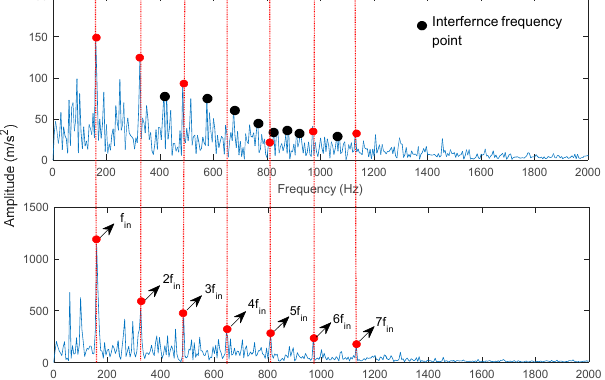
Figure 25. Comparison of computational cost for ECEEMDAN and CEEMDAN. 4.4.2. Case 2 Bearing with an Outer Raceway Fault In this section, ECEEMDAN is used to decompose the fault signal. A total of 14 IMFs were obtained under the condition of the optimal decomposition level (10 − 6 ). Then, the CF was employed to identify the IIM (Figure 26). The results show that CF 1 is the maximum, meaning that the first IMF contains the main information of the vibration signal. Meanwhile, complete ensemble local mean decomposition with adaptive noise ( CELMDAN) -kurtosis and variational mode decomposition (VMD) -kurtosis [36] are also utilized to extract the IIM. Figure 27 shows the identified result of IIM for the two methods. Moreover, minimum entropy deconvolution (MED) [37] combined with autoregressive filter (AR) (MED-AR) was used to identify the fault frequency. The first and the forth IMF were the identified IIMs for CELMDAN kurtosis and VMD kurtosis, respectively.